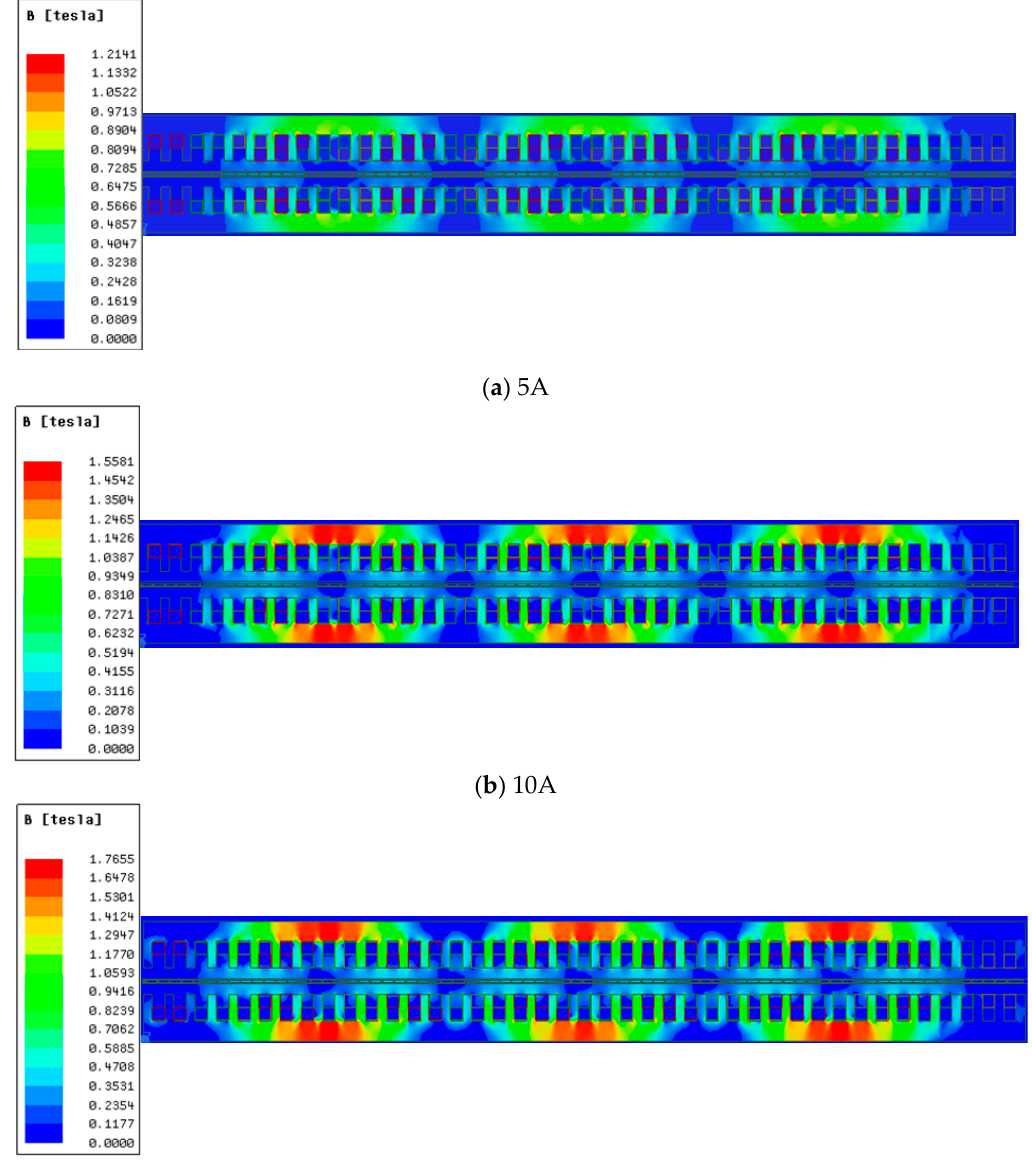
Figure 10. Magnetic density distribution at different currents.